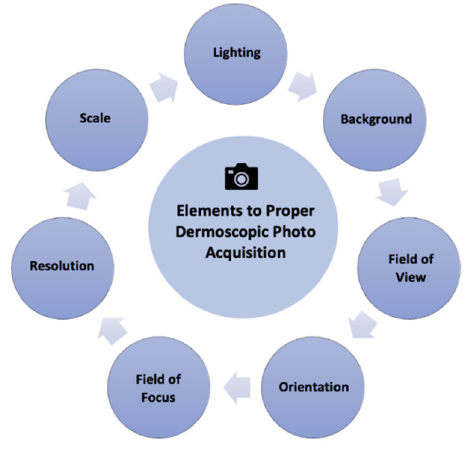
Figure 4. Key elements for the successful acquisition of clinical images for asynchronous telederma- tology consultations. Important delivery considerations include appropriate lighting, background, field of view, orientation, focus, field, resolution, and photo scale.